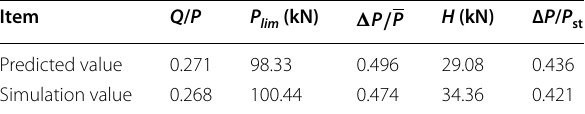
Table 8 Safety metrics after optimization